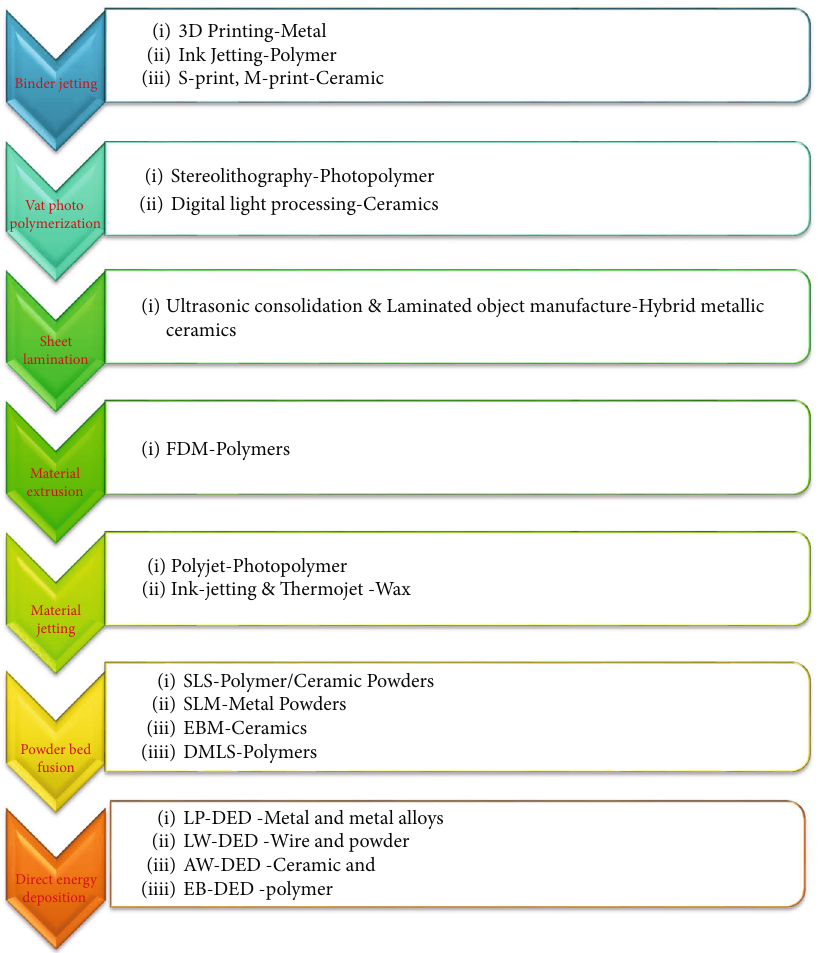
Figure 3: Di ff erent processes/technologies/materials in additive manufacturing [38 – 41].